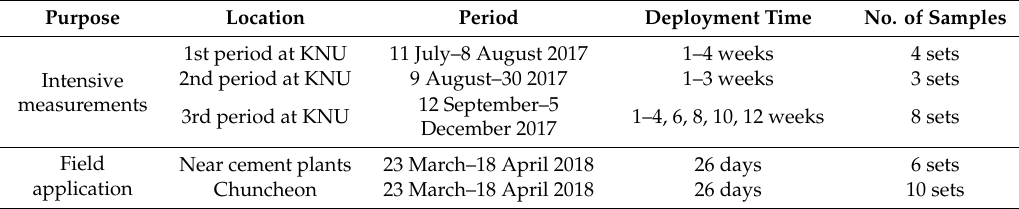
Figure 2. Sampling sites in Korea. The passive sampler was evaluated at Kangwon National University (the blue diamond) in Chuncheon (blue area), Korea during three intensive sampling periods. After intensive sampling, the samplers were applied near six cement production facilities (red circles) in Korea. Table 1. Description of measurement periods and locations in this